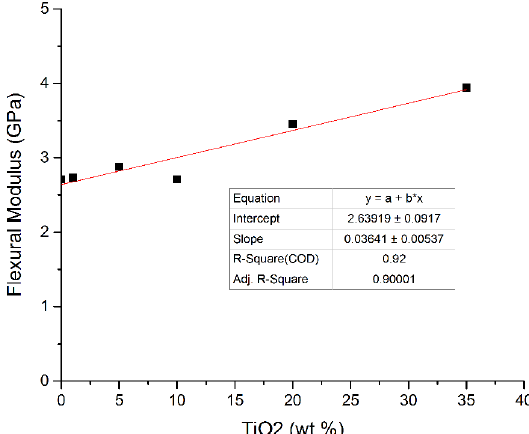
Figure 4. The compressive strength of the TiO